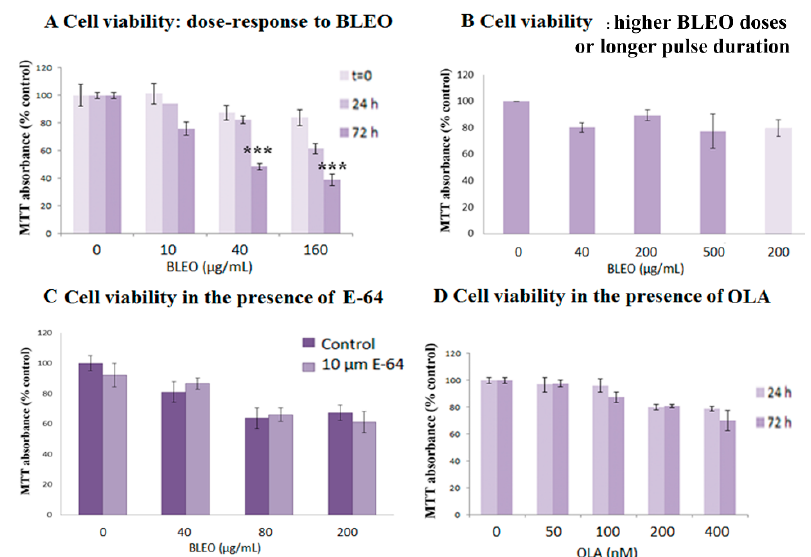
Figure A1. BLEO and OLA curves. Cell viability (MTT assay). ( A ) Cells were exposed to BLEO in the indicated doses (0–160 µg/mL) during a 45 min pulse. Then, cells were cultured during the indicated time before the MTT addition (0, 24, or 72 h, where “t = 0” refers to immediately after the treatment). The 2018–2020 dataset includes 20 MTT experiments with BLEO in VERO cells. At 72 h, n = 63, 6, 72, and 22 for increasing BLEO concentrations. Fewer data were recorded for shorter times and are depicted to facilitate understanding of the chosen schedule. ***: p < 0.001. ( B ) Cell viability (24 h) under higher BLEO doses or longer BLEO pulse durations. Cells were exposed to BLEO in the indicated doses (0–500 µg/mL) during a 45 min pulse or (last bar) during 270 min. ( C ) Cell viability (24 h) in the control and BLEO-exposed cells in the absence or presence of a co-treatment (45 min pulse) with bleomycin hydrolase inhibitor E64. ( D ) Cell viability after exposure to OLA (0–400 nM). The whole curve was done once at 24 h and once at 72 h. In contrast, for 50 nM Olaparib at 72 h, n = 75 from 12 independent experiments.